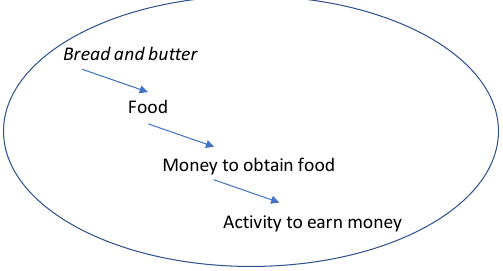
Figure 2. Metonymic complex underlying the interpretation of bread and butter.